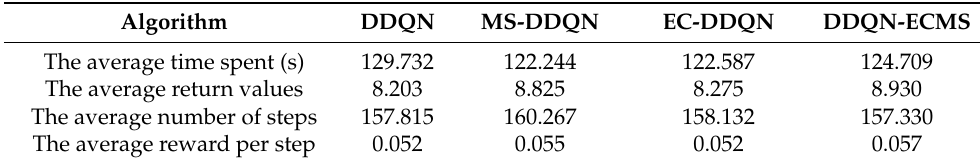
Table 2. Performance comparison of four different algorithms in a fixed position scene.